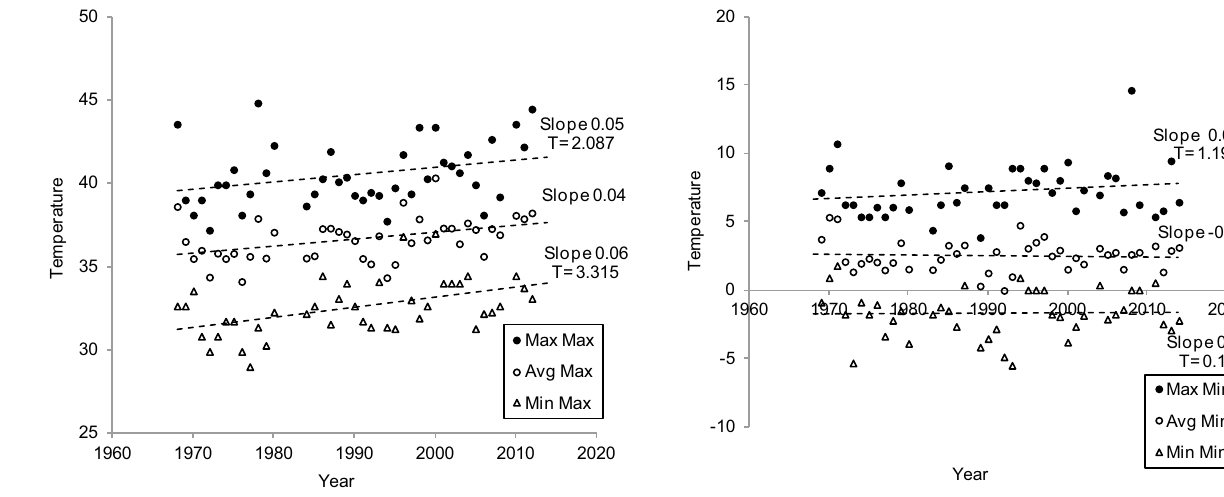
Fig. 5 Monthly minimum temperature in January